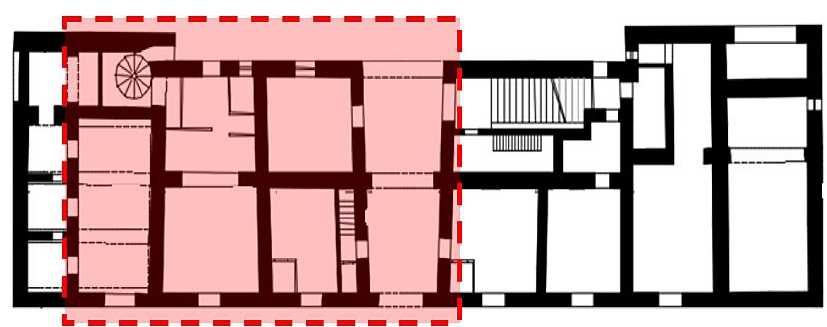
Figure 4. Intermediate structural unit in aggregate condition.